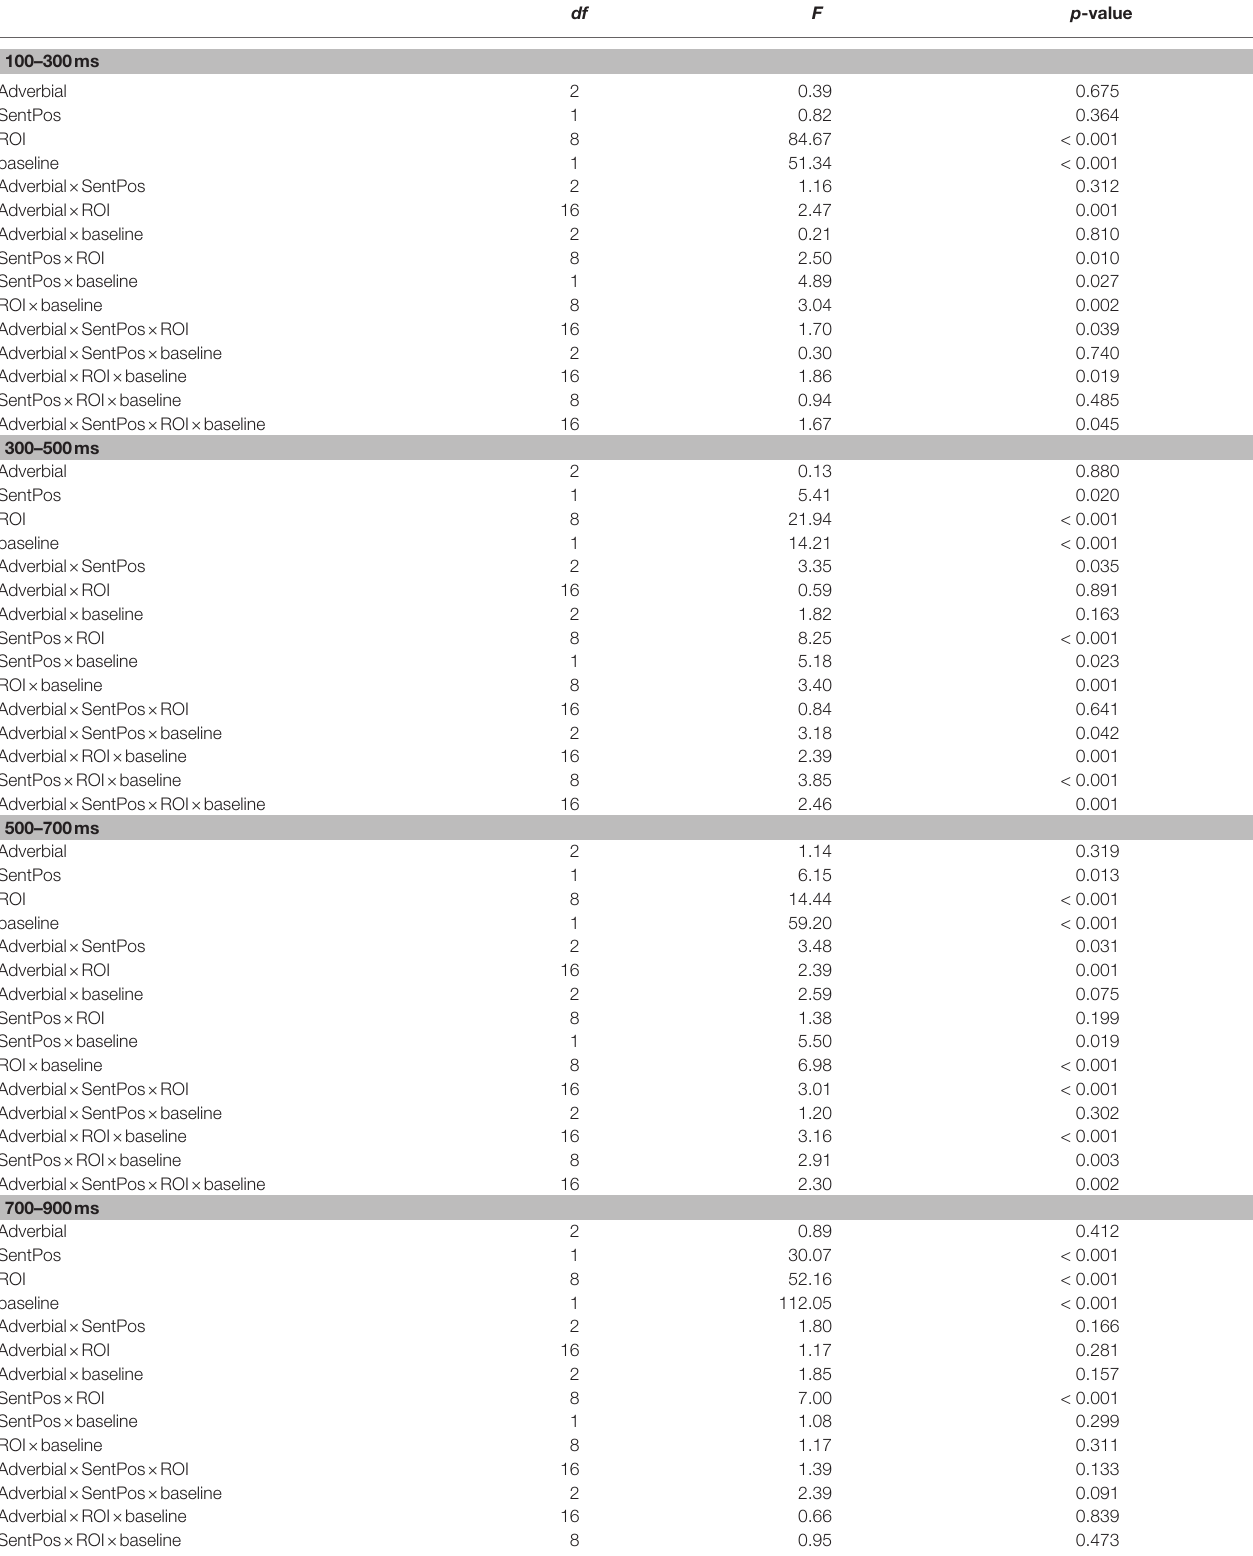
TABLE 5 | Results of the LME model for Adverbial, Sentence Position, ROI and baseline. df F p